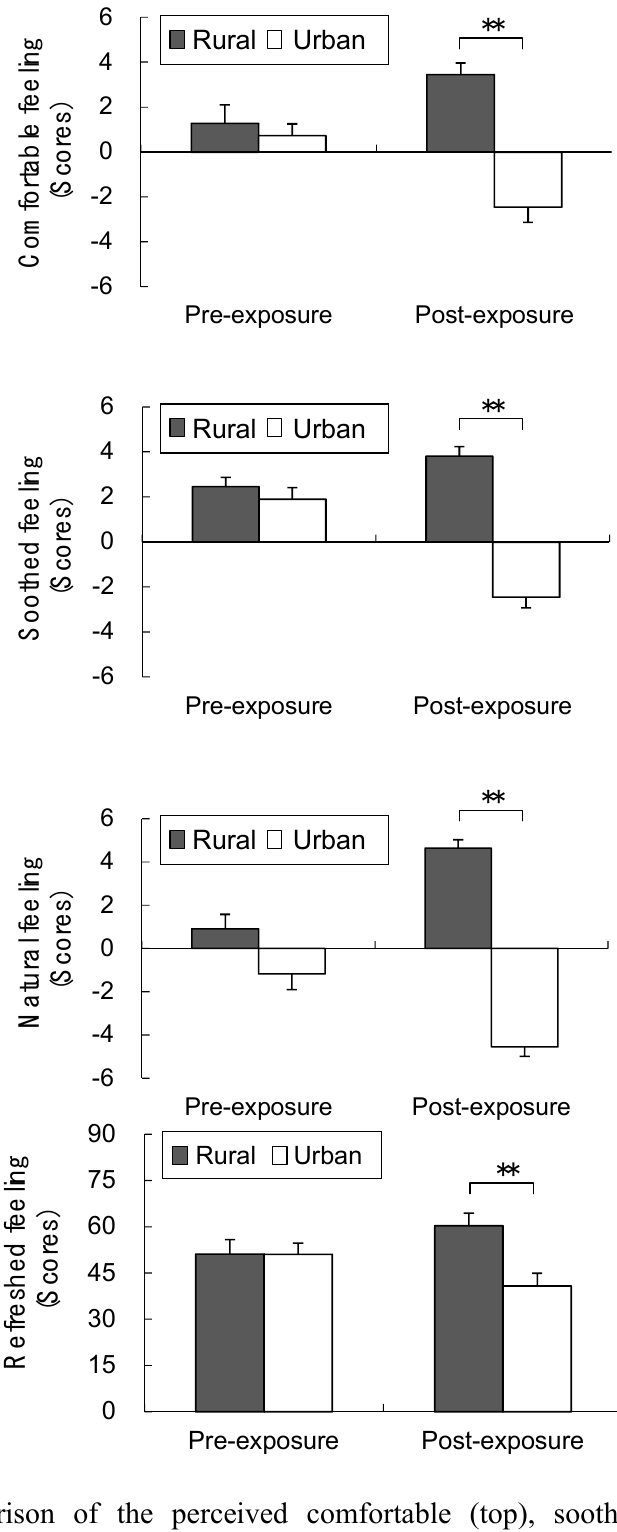
Figure 6. Comparison of the perceived comfortable (top), soothed (upper middle), natural (lower middle), and refreshed feelings (bottom) between the rural and urban environments at pre- and post- exposure sessions. Mean ± SE; N = 11; ** p < 0.01; Wilcoxon signed-rank